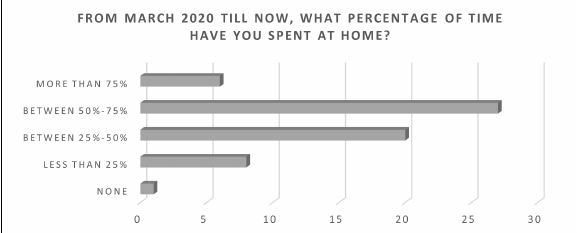
Figure 5: Frequency distribution of the time subjects spent at home, in the period between March 2020 and the current situation.